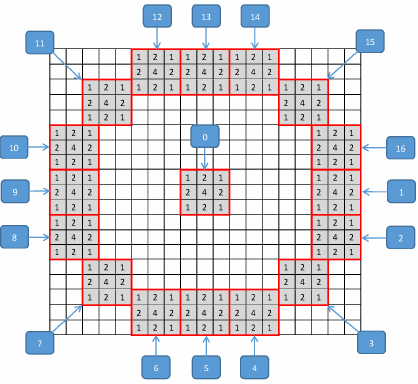
Figure 2. The local processing window and Gaussian